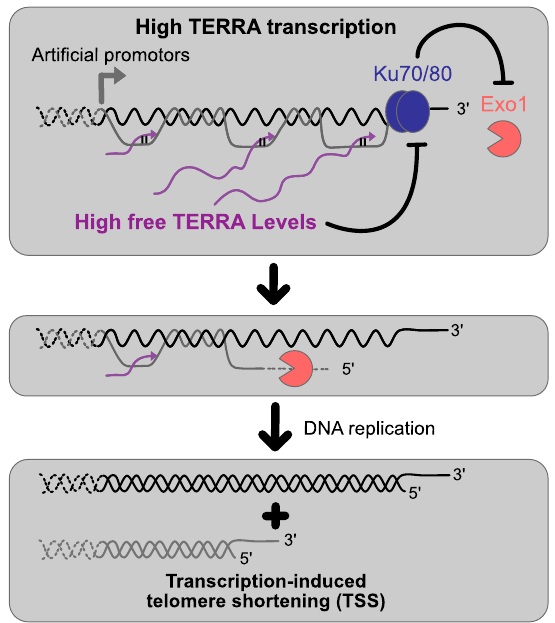
Figure 3. Effects of high TERRA transcription on telomere length homeostasis. The induction of TERRA transcription by artificial promoters results in high TERRA levels which promote Exo1-dependent 5'-3' resection at telomeres by impairing the Ku complex functions resulting in transcription-induced telomere shortening in cis .